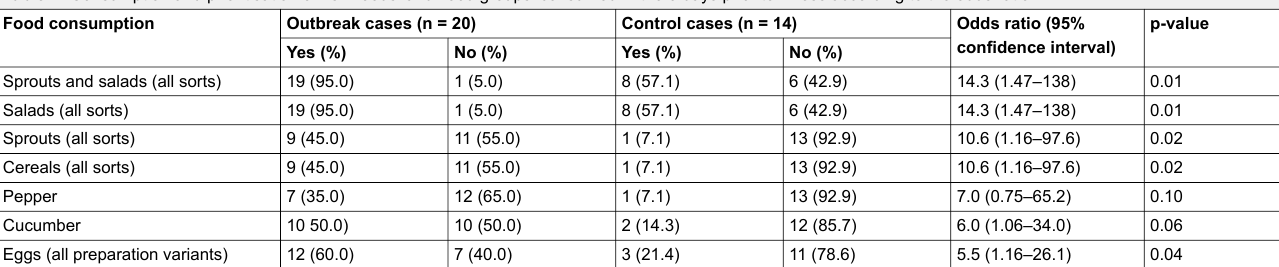
Table 1: Consumption and prioritisation of risk ‘foods’ and ‘food groups’ consumed in the 3 days prior to illness according to the odds